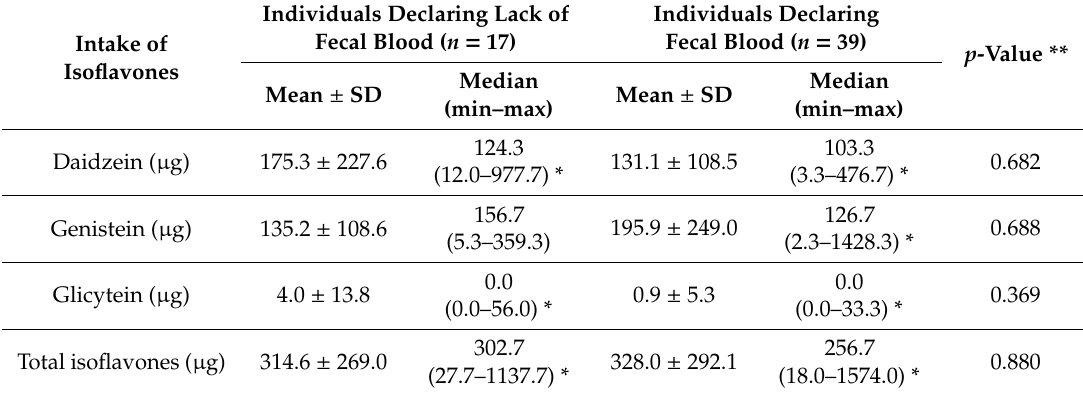
Table 2. The isoflavone intakes in groups of individuals with ulcerative colitis declaring either lack or presence of fecal blood.